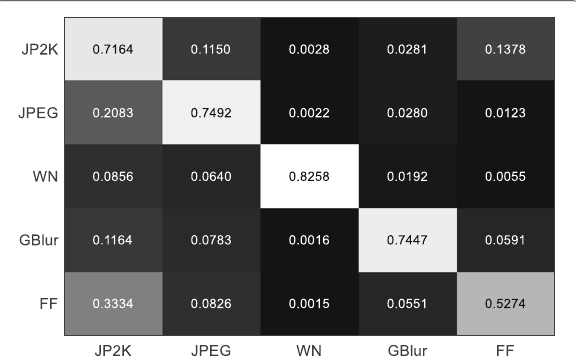
Fig. 7 Mean confusion matrix of the classification accuracy across 1000 train-test